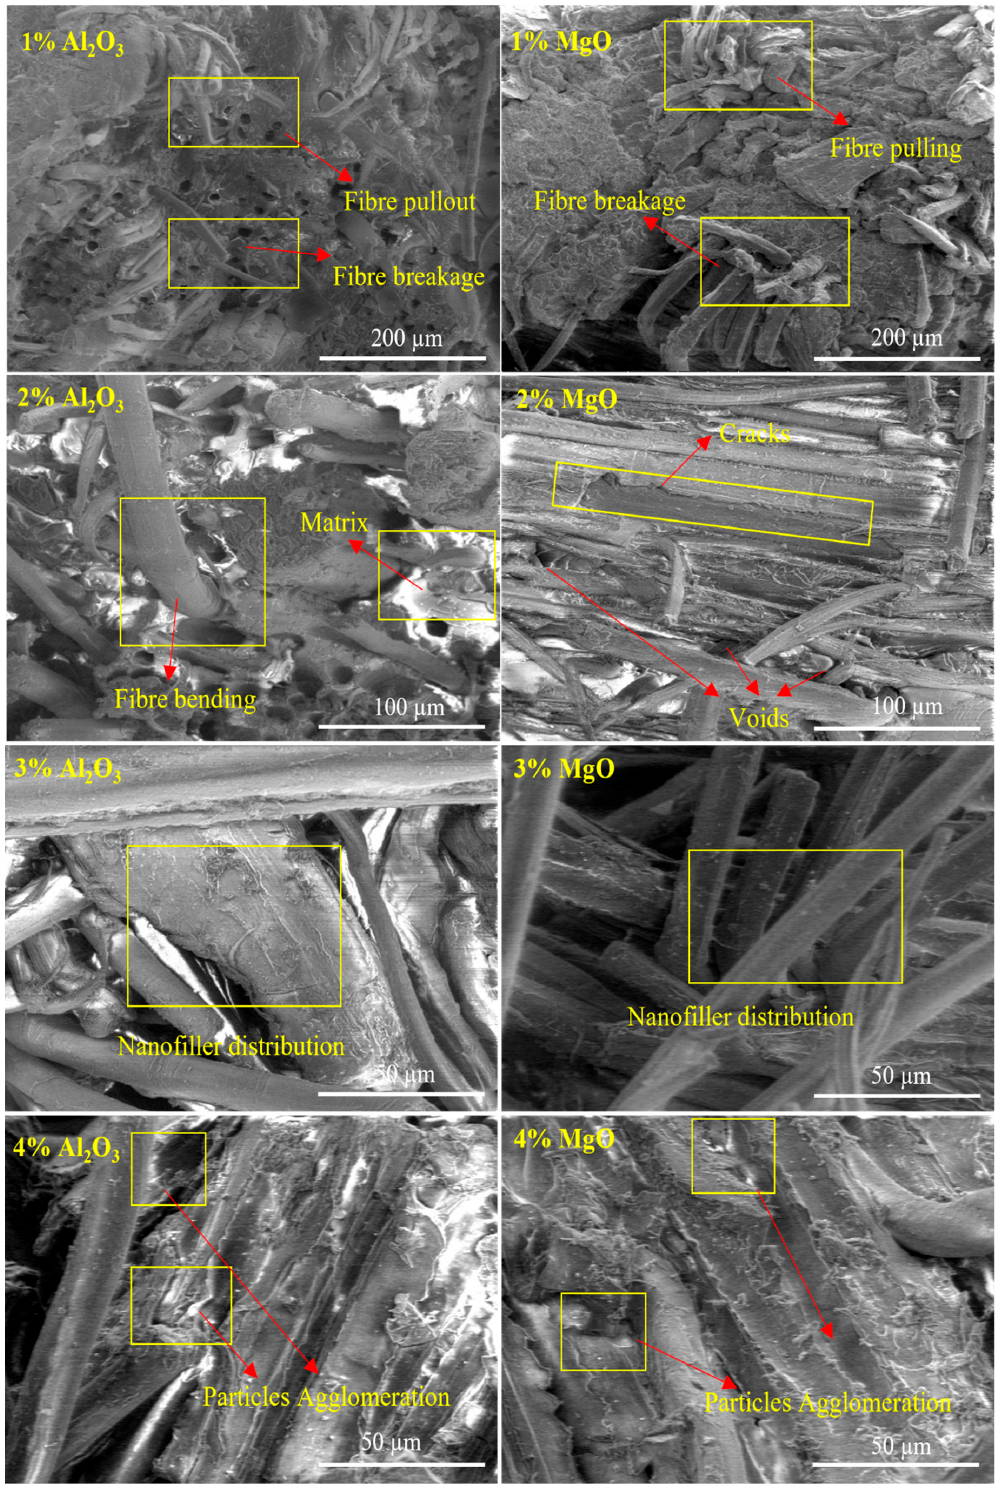
Figure 7. SEM images of alkali-treated biotex flax/PLA reinforced epoxy composite at different percentage of nano-Al 2 O 3 and nano-MgO.